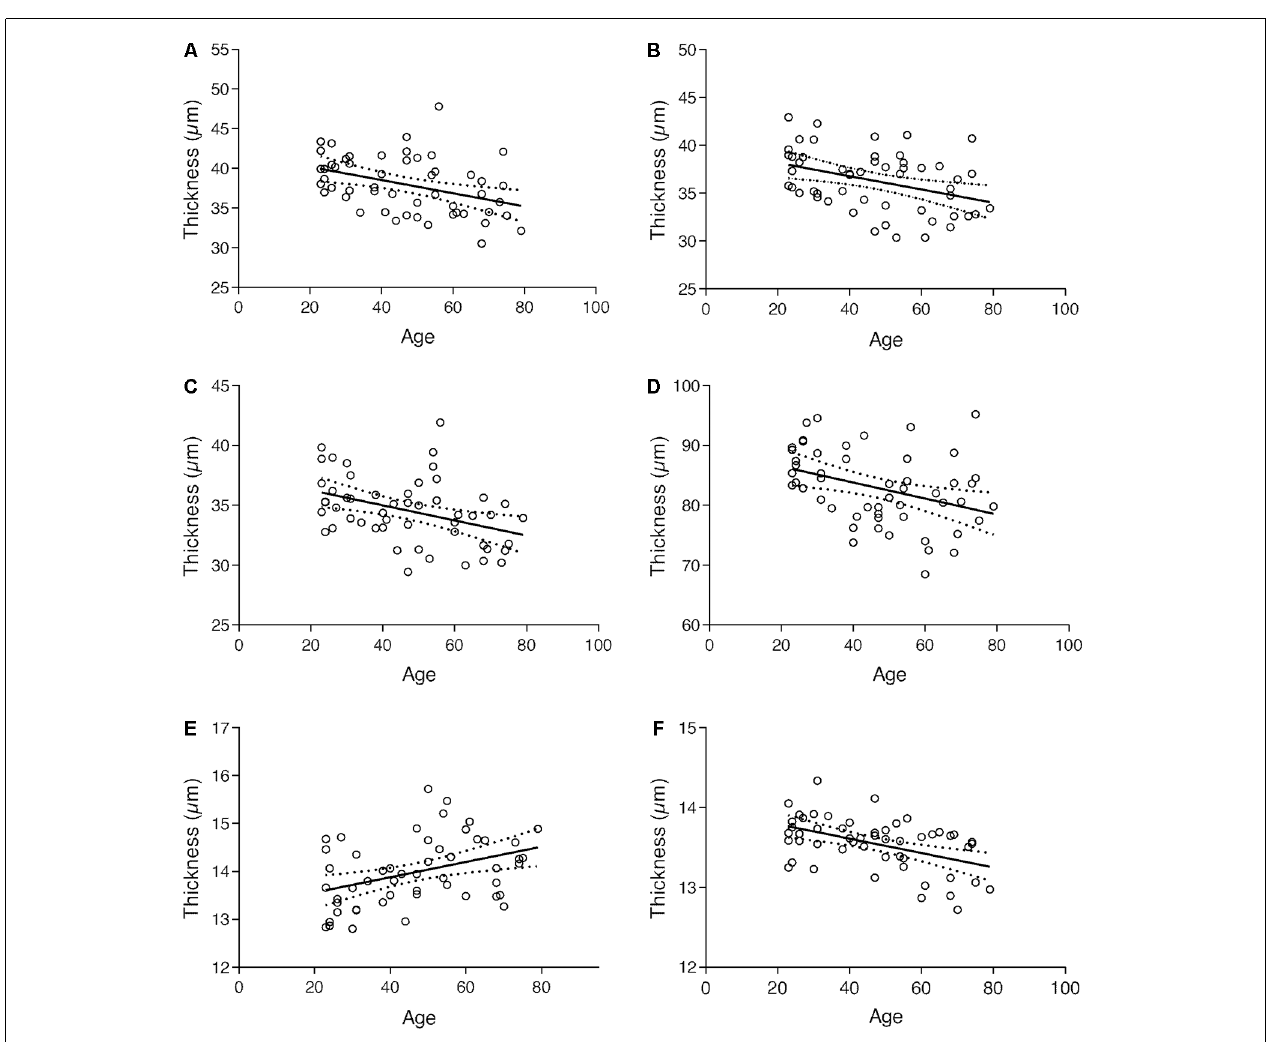
FIGURE 5 | Regression plot of (A) GCL; (B) IPL; (C) INL; (D) ONL; (E) OS and (F) OPR thickness vs. age and 95% confidence intervals for the regression line.